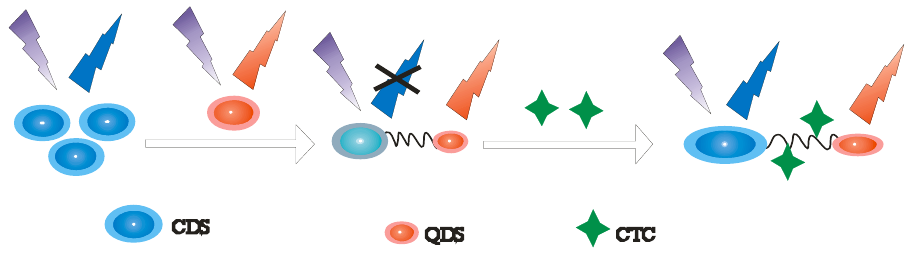
Figure 15. Simplified diagram of fluorescence sensor layout for ratiometric detection of chlorotetracycline.